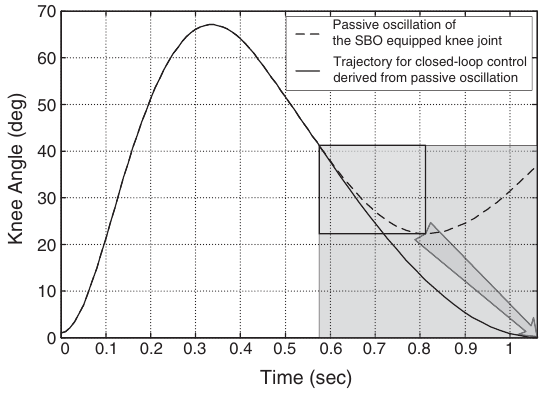
Fig.6. ReferencekneejointtrajectoryforSBOcontrolderivedfrom observing pure passive oscillation of the knee joint.